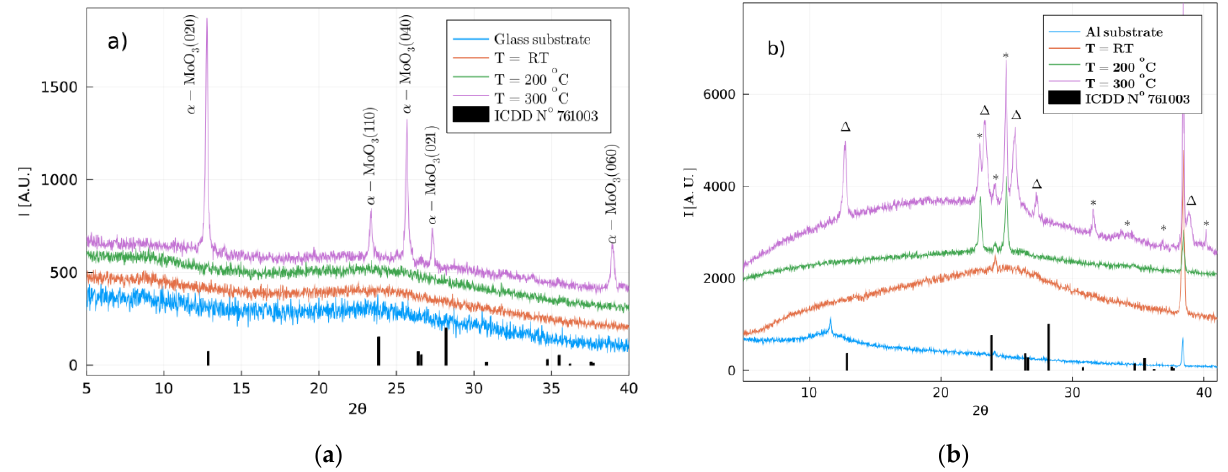
Figure 2. ( a ) XRD patterns of MoO 3 sputtered on aluminum substrate ( Δ : orthorhombic α -MoO 3 , *: Al-oxides), ( b ) crystallinity was estimated with the presented numerical procedure. The peak positions were given manually, the fitting is linear. The blue line is the original sample diffractogram, the orange one is the amorphous background, and the green is the studied crystalline phase.